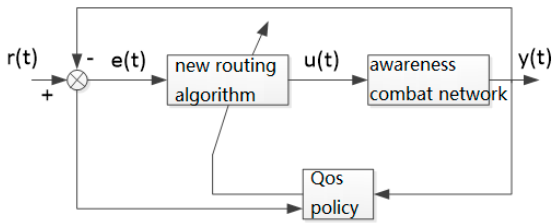
Figure 1. Closed-loop routing control model of the awareness combat network.